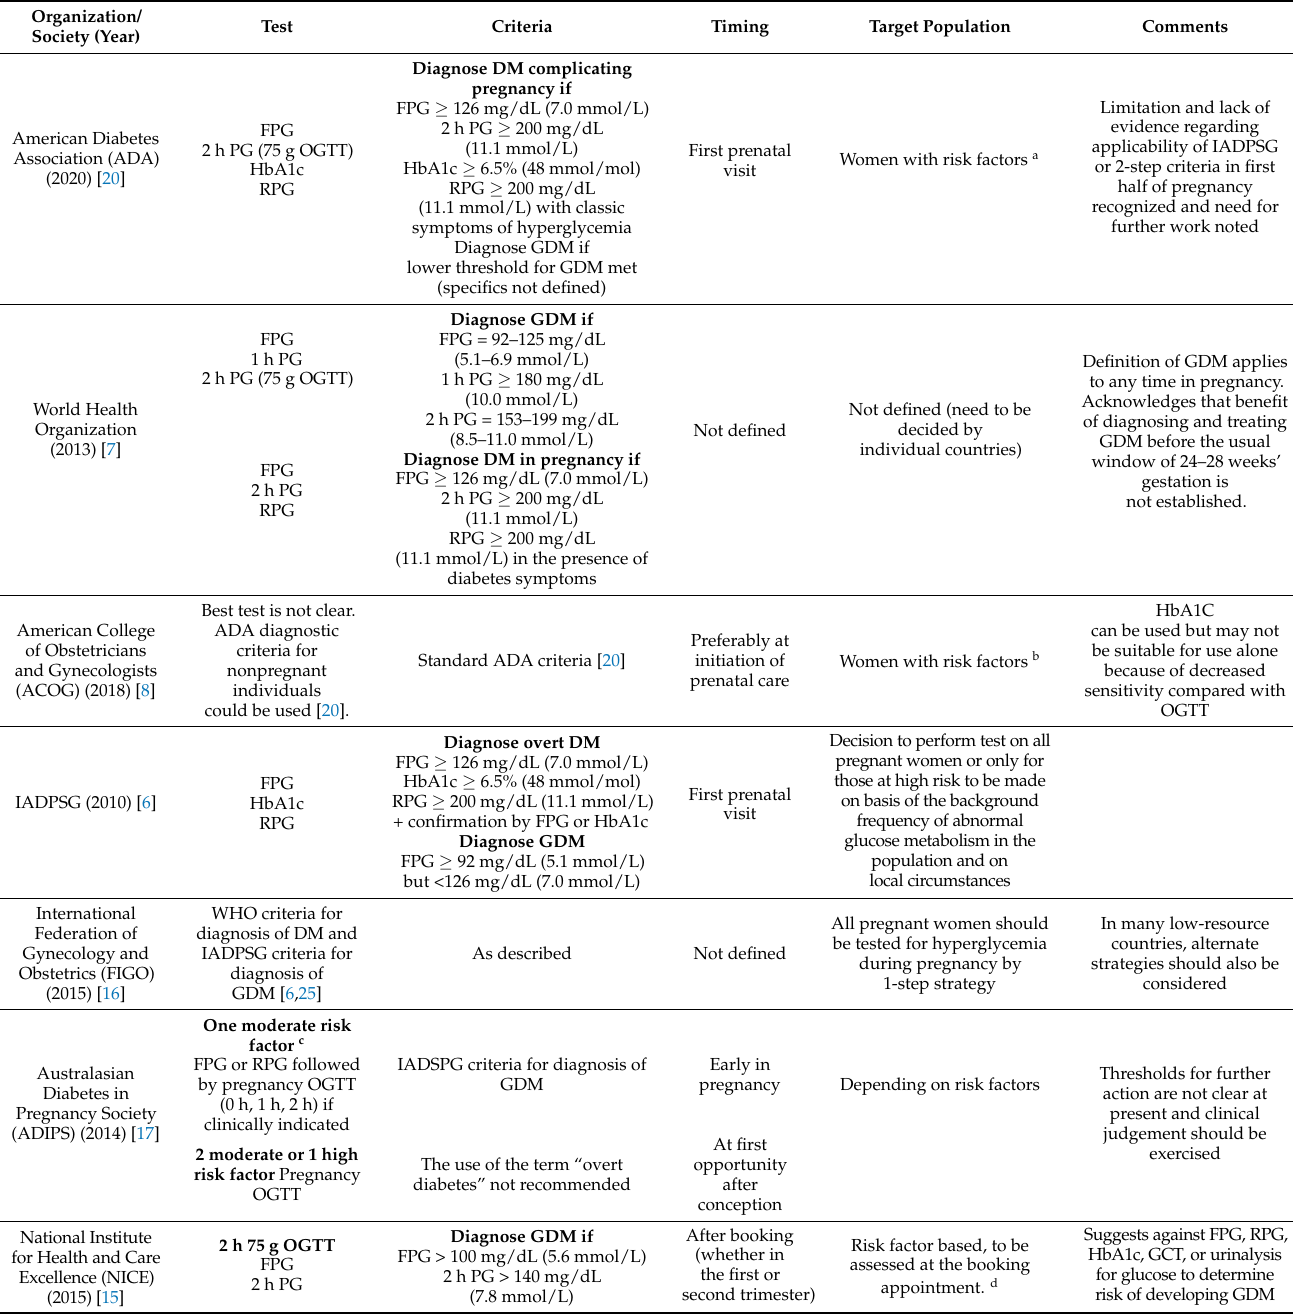
Table 2. Screening methodology suggested by different organizations for diagnosing hyperglycemia early in